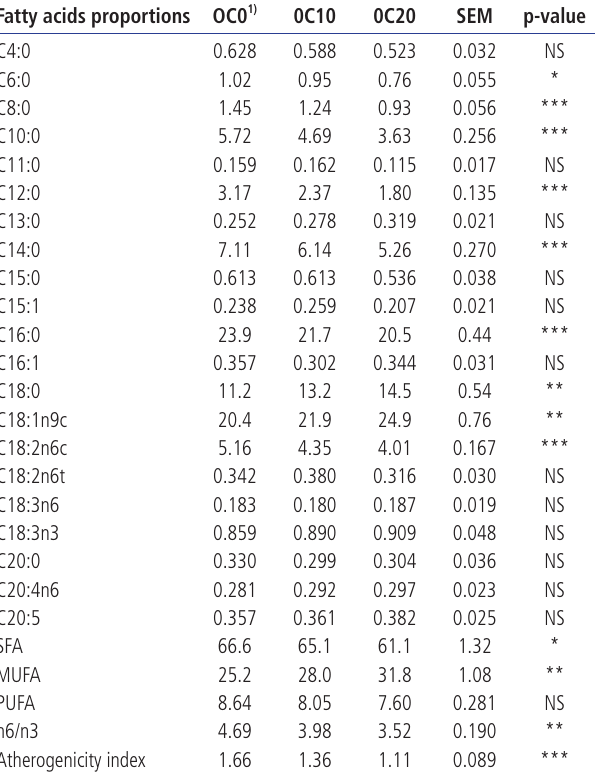
Table 5. Effects of two levels of OCS on proportional fatty acid composition of milk fat (proportions of the total fatty acid methyl esters) Fatty acids proportions OC0 1)